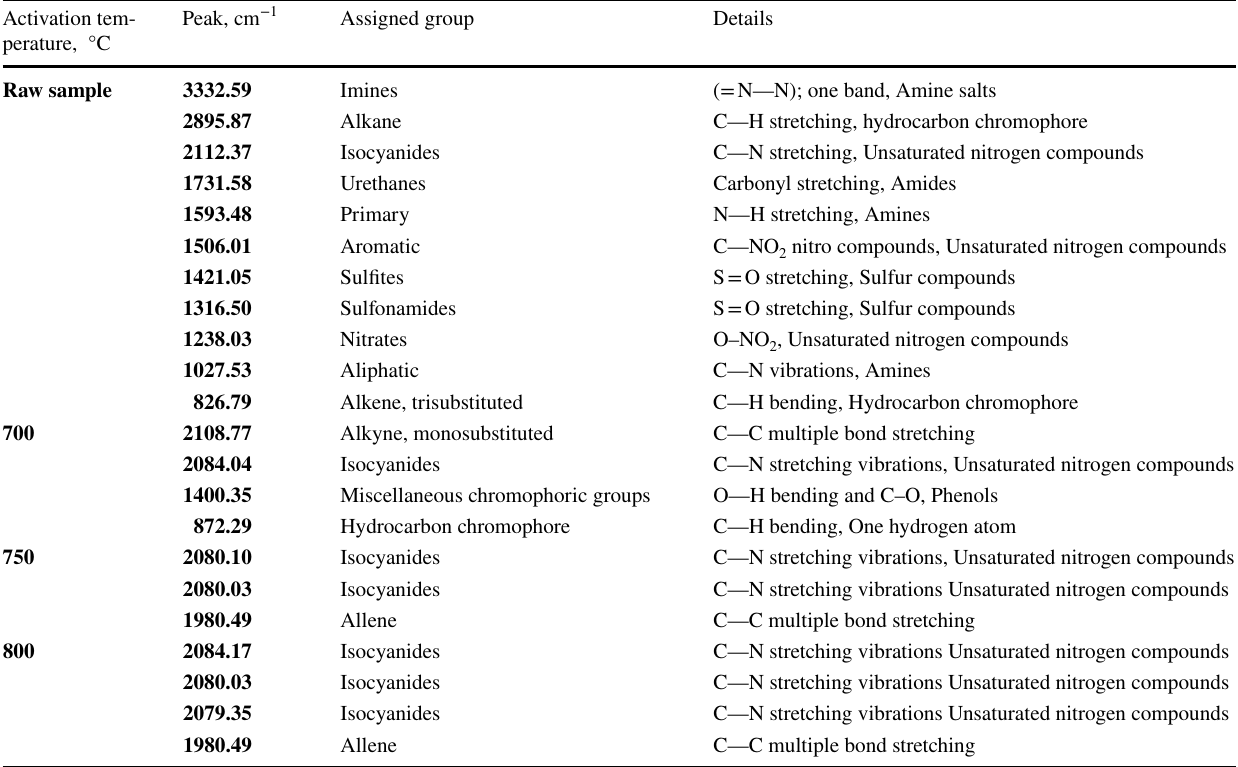
Table 4 Detail interpretation of FT-IR spectra Activation tem- perature, °C